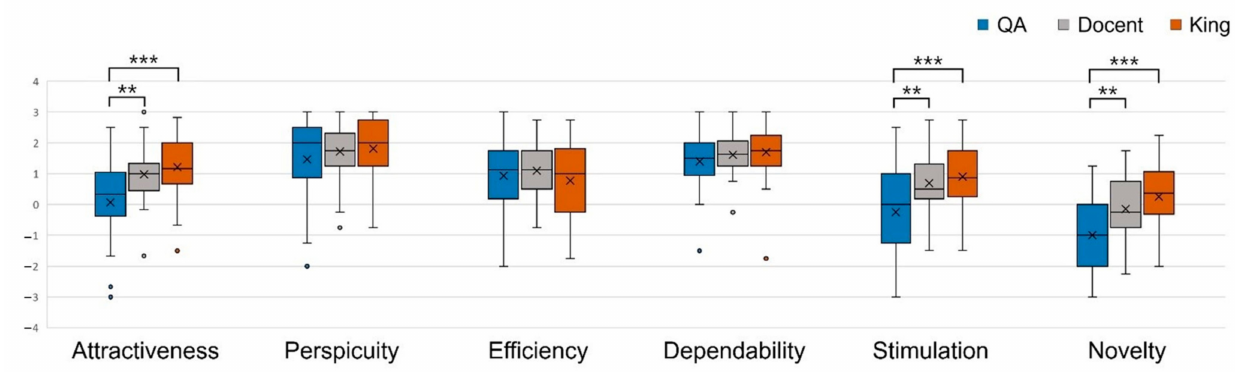
Figure 2. UEQ results on the three chatbot models. (significance p -value **: p < 0.01, ***: p <